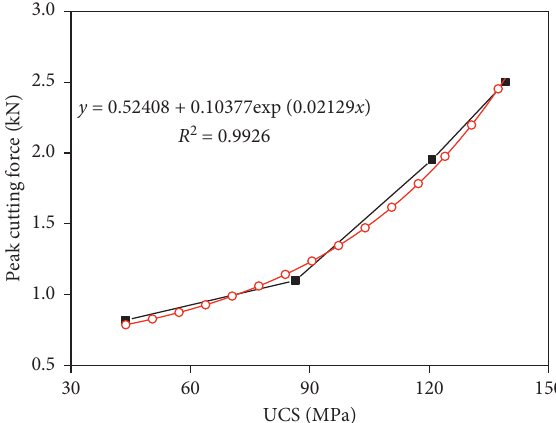
Figure 21: Relationship between UCS and peak cutting